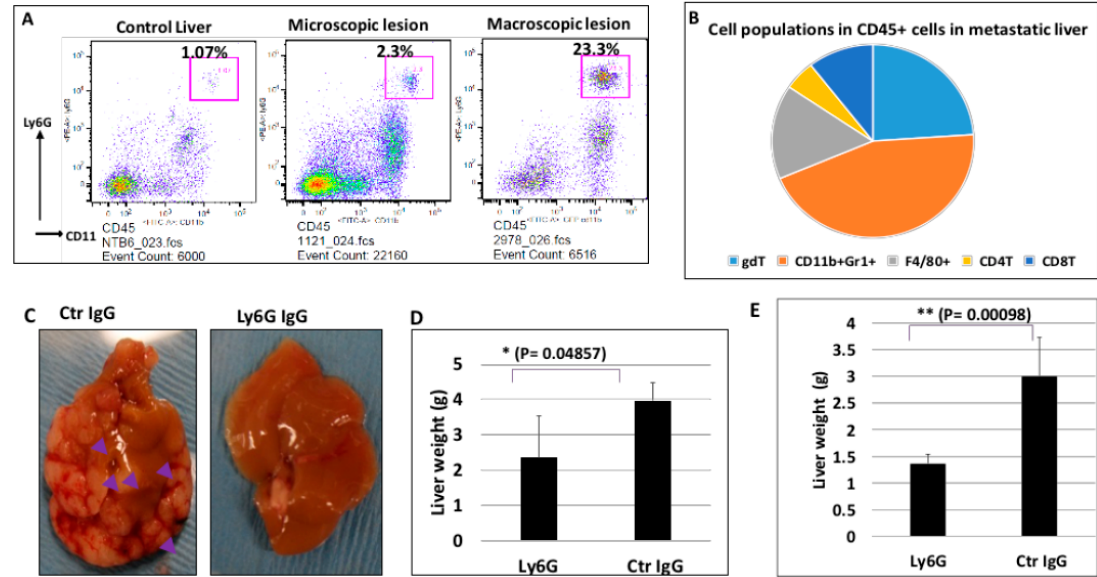
Figure 5. Effects of MEK/Hh signaling inhibition on Ly6G + CD11b + cells in the metastatic liver tissues (MMC18-based model in immune competent C57/B6 mice). ( A ) Representative images of flow cytometry of CD45 + CD11b + Gr1 + cells in different liver tissues; ( B ) Cell population composition in metastatic liver tissues, and the number was the average from five mice/group; ( C ) Representative images of liver tissues with or without treatment of Ly6G neutralizing antibodies. While IgG treated mice had many metastatic nodules (indicated by purple arrowheads), Ly6G neutralizing antibody treatment led to no visible or only a few metastatic nodules; ( D ) Ly6G neutralizing antibody treatment led to reduced liver weight in MMC18- based mouse model (five mice/group), suggesting a reduced liver metastasis; ( E ) Similar results were obtained using Pan02 cells (five mice/group). Ly6G neutralizing antibody treatment led to reduced liver weight. * p values were calculated using Student t test of two independent